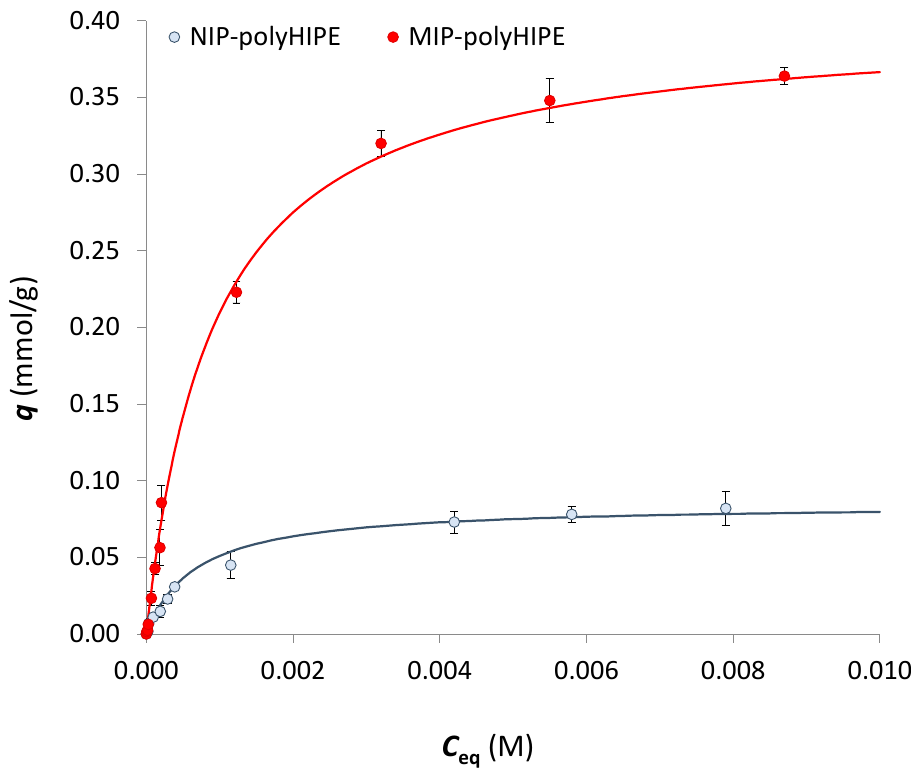
Figure 4. Sorption isotherm of IRB on the washed MIP-polyHIPE (1:15, red dots) and NIP-polyHIPE (grey dots). Discontinuous procedure: 15 mg of sorbent contacted with 0.1 M acetate buffer at pH 5 containing increasing amounts of IRB (from 8 µM to 8 mM). Continuous lines are the fitting by Langmuir equation. Experimental points are reported as average values of five replicates, and the error bars correspond to the standard deviation.